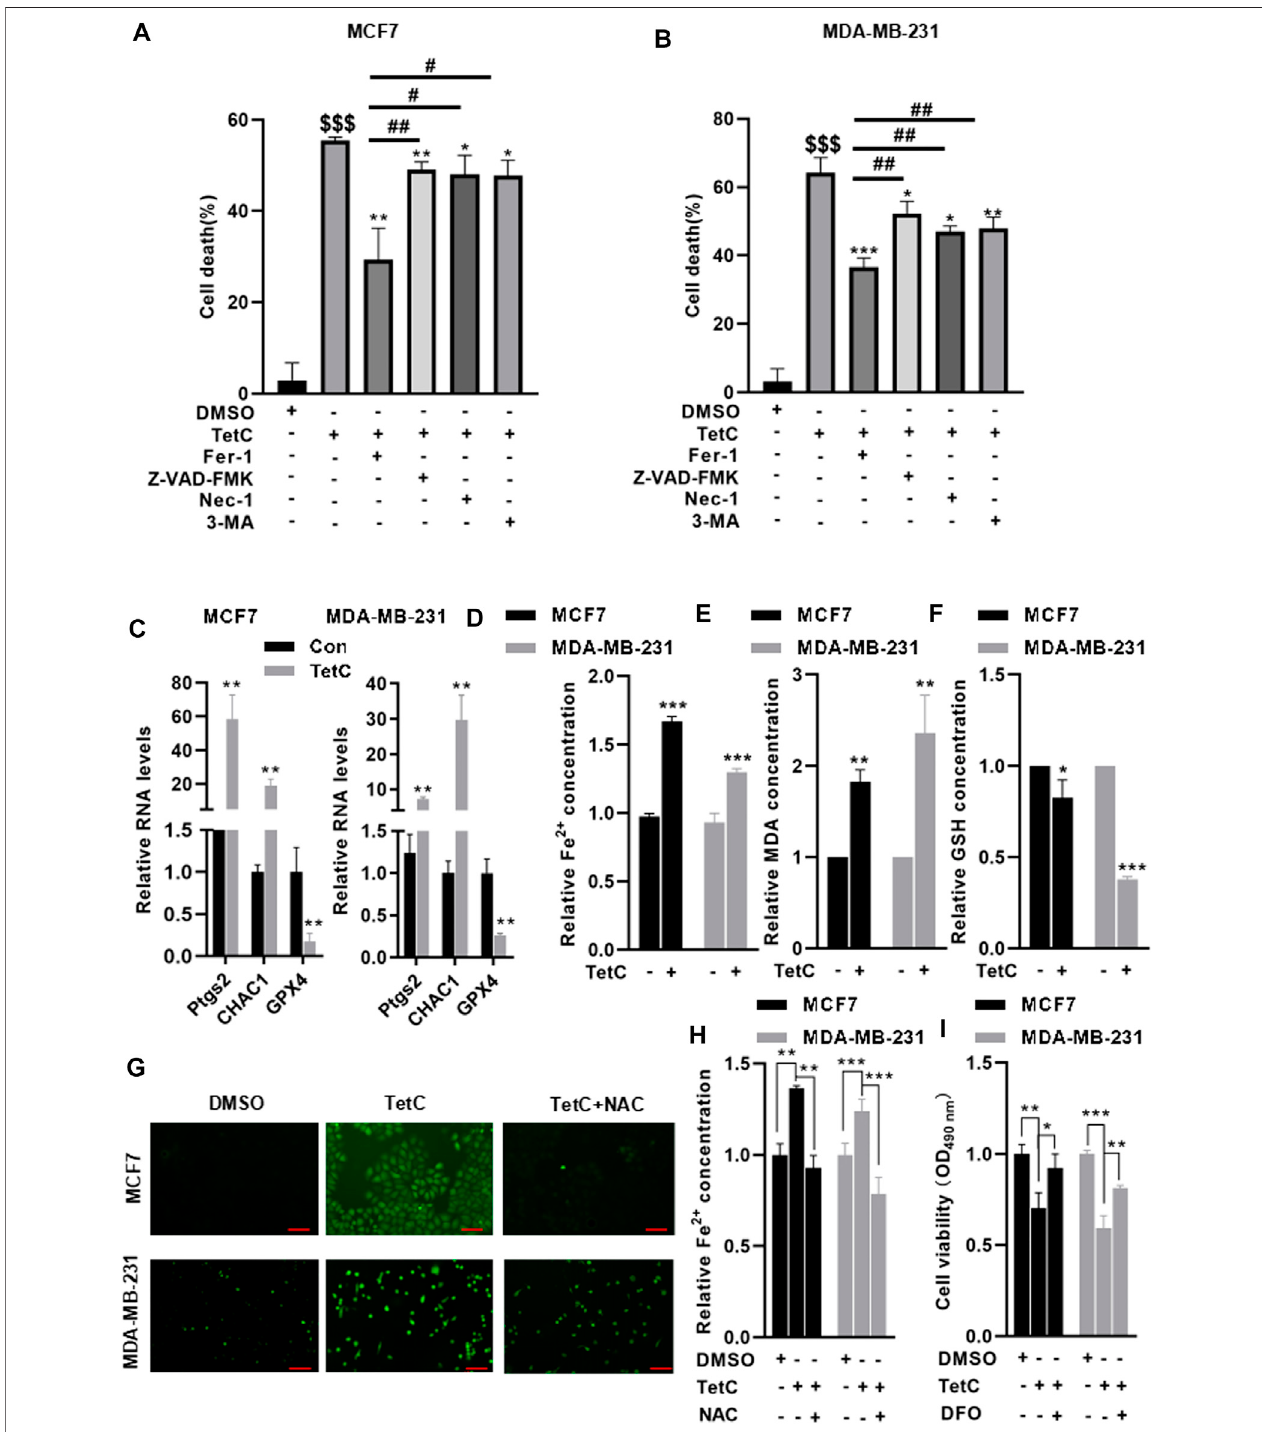
FIGURE 3 | TetC drives ferroptosis in BC cells. MCF7 and MDA-MB-231 cells were preincubated with or without 1 μ M Fer-1, 20 μ M Z-VAD-FMK, 20 μ M Nec-1, and 20 μ M 3-MA for 1 h. Then, MCF7 and MDA-MB-231 cells were treated with 20 μ M or 10 μ M TetC for 24 h. MTT assay showed that compared with z-VAD-FMK, Nec-1, and 3-MA, Fer-1 demonstrated the potent cell death inhibitory effects in MCF7 (A) and MDA-MB-231 (B) cells. (C) RT-PCR analysis showed that TetC signi fi cantly upregulated the mRNA levels of Ptgs2 and Chac1 in BC cells but reduced GPX4 mRNA levels compared with those of control. TetC elevated the intracellular contents of Fe 2+ (D) and MDA (E) but decreased the contents of GSH (F) in MCF7 and MDA-MB-231 cells. MCF7 and MDA-MB-231 cells were preincubated with10 μ M NAC or 10 μ M DFO for 2h, followed by TetC treatementfor another 24 h. DCFH-DA staining showed thatTetC-induced accumulation ofROS could be largely attenuated by preincubation with NAC in both MCF7 and MDA-MB-231 cells; scale bar, 100 µm. (G) Upregulation of Fe 2+ induced by TetC was also reversed by NAC preincubation in MCF7 and MDA-MB-231 cells (H) . (I) MTT assay showed that DFO signi fi cantly reversed TetC-induced cell death ( n = 3 independent repeats). $$$ p < 0.001 vs. DMSO; * p < 0.05; ** p < 0.01; *** p < 0.001 vs. TetC; # p < 0.05; ## p < 0.01 vs. TetC +